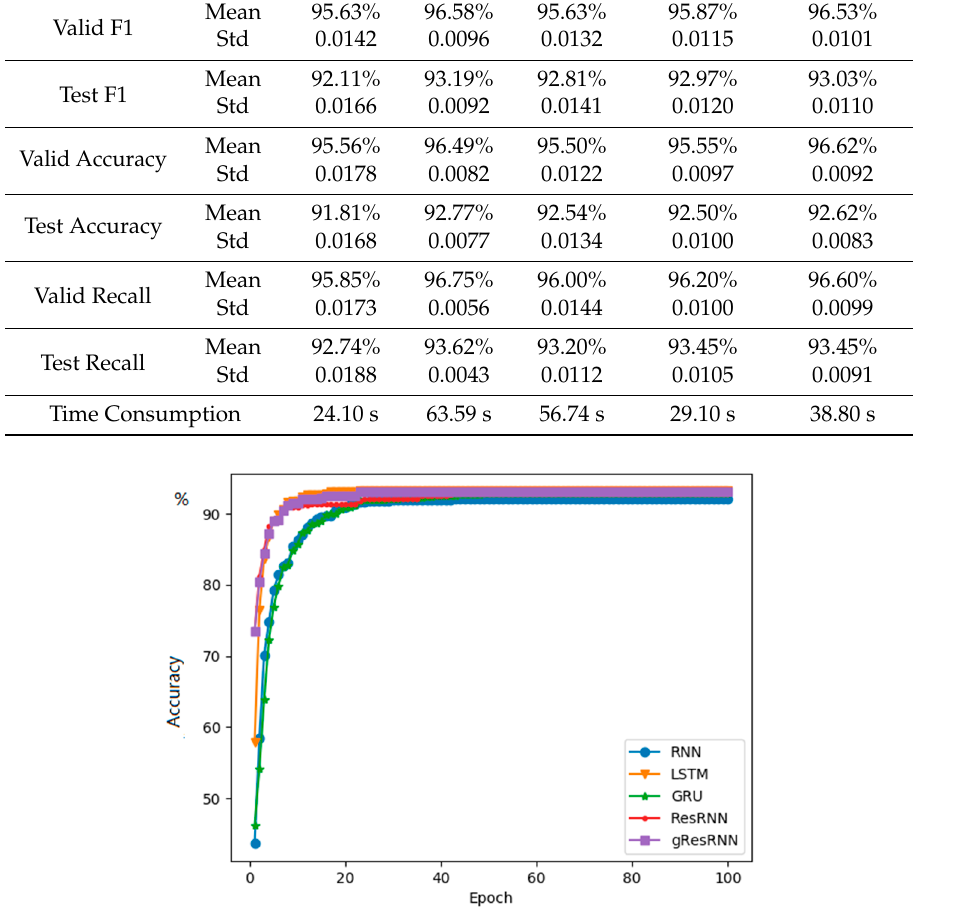
Table 2. Performance of the RNN [9], LSTM [16] and GRU [17], Res-RNN and Res-RNN with gates on the Internet movie database (IMDB) in 20 epochs.